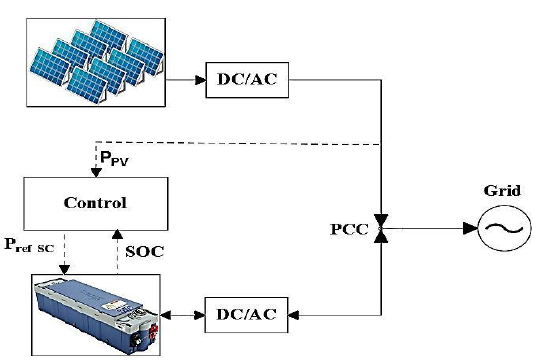
Figure 5. Photovoltaic solar system and supercapacitors connection diagram.